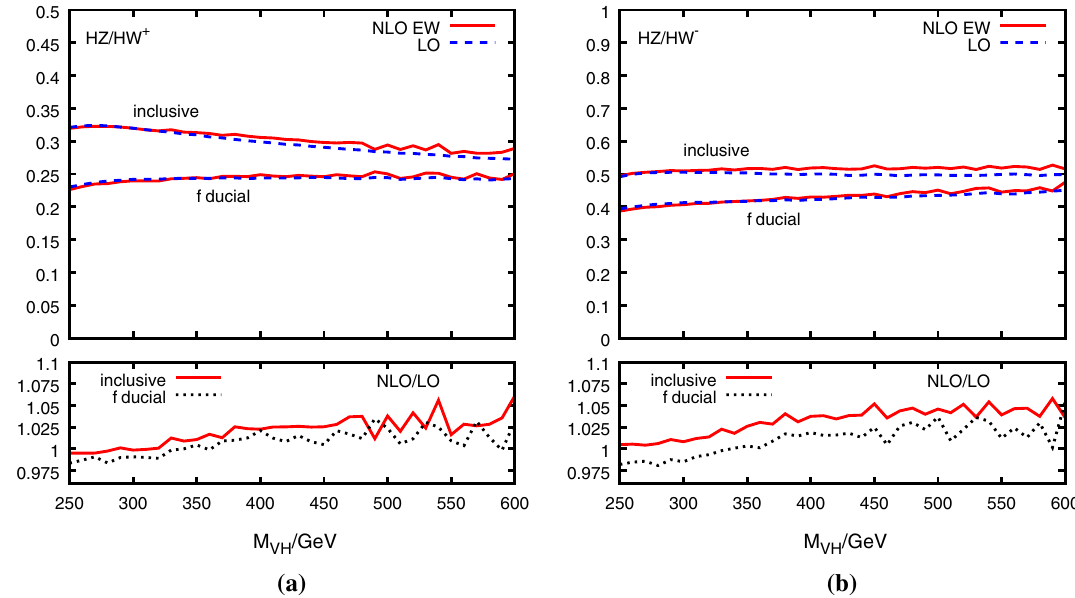
Fig. 5 a , b Same as Fig.4, but for electro-weak corrections ( ex cluding γ q → qVH )